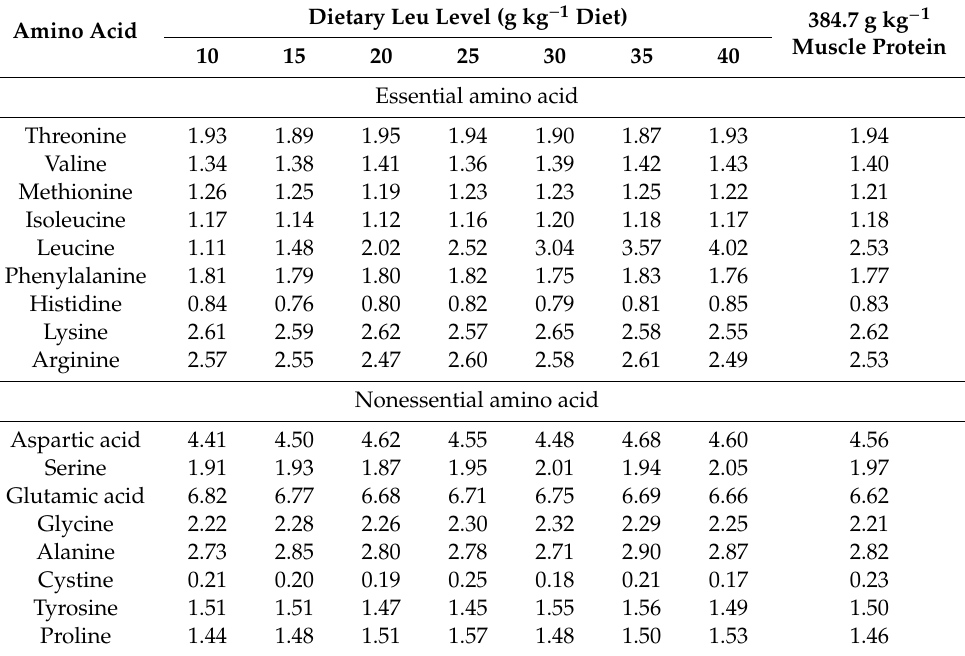
Table 2. Amino acid composition of the experimental diets (% dry diet) and fish muscle (relative